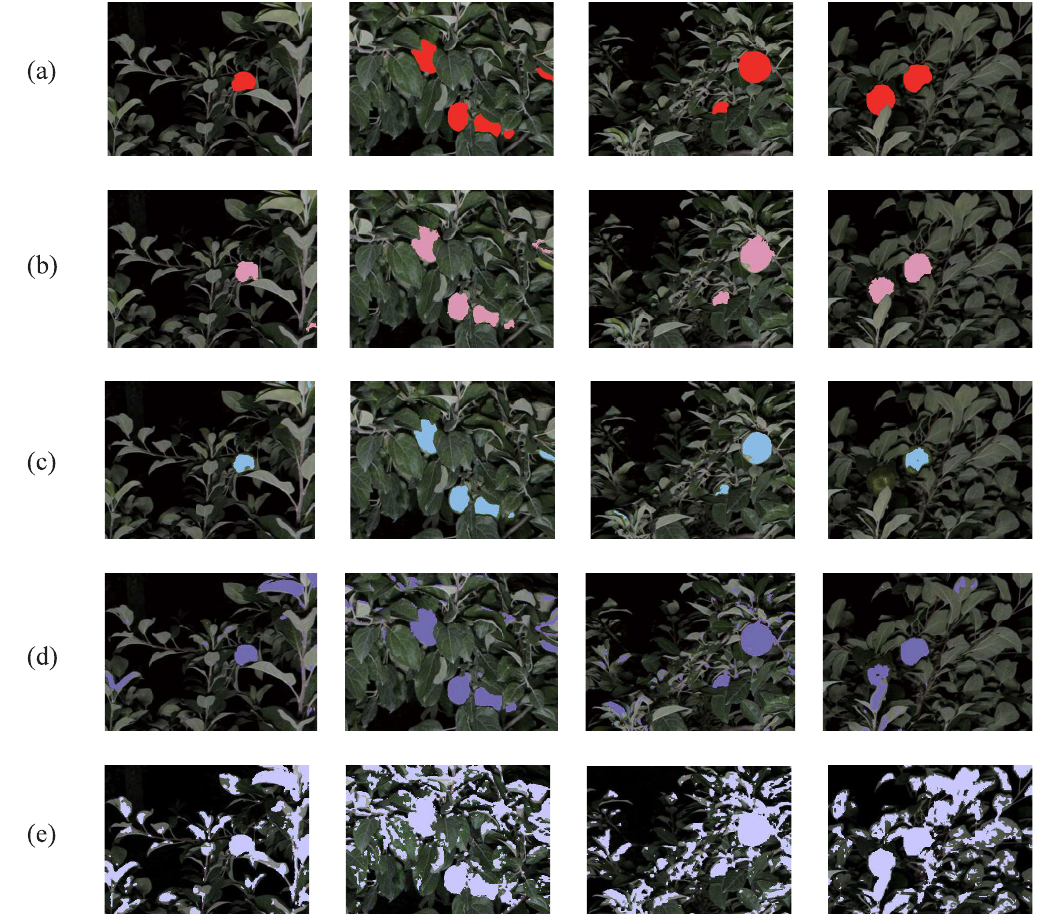
Figure 10. Mannually labeling results and algorithm segmentation results: ( a ) Mannually labeling results, ( b ) This designed segmentation method results, ( c ) Otsu based on R-B and boundary object removal, ( d ) K-means cluster segmentation method based on R-B, ( e ) Adaptive threshold segmentation method based on